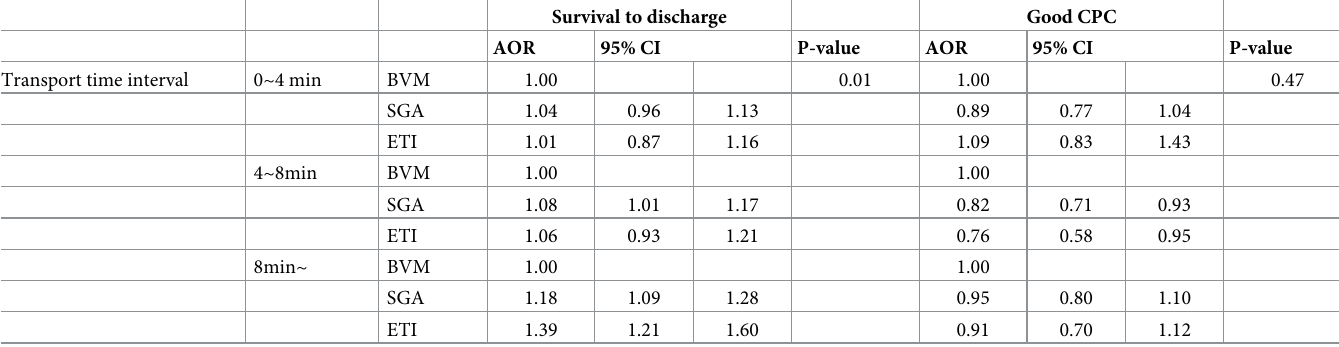
Table 4. Interaction analysis for outcomes of prehospital airway management technique according to transport time